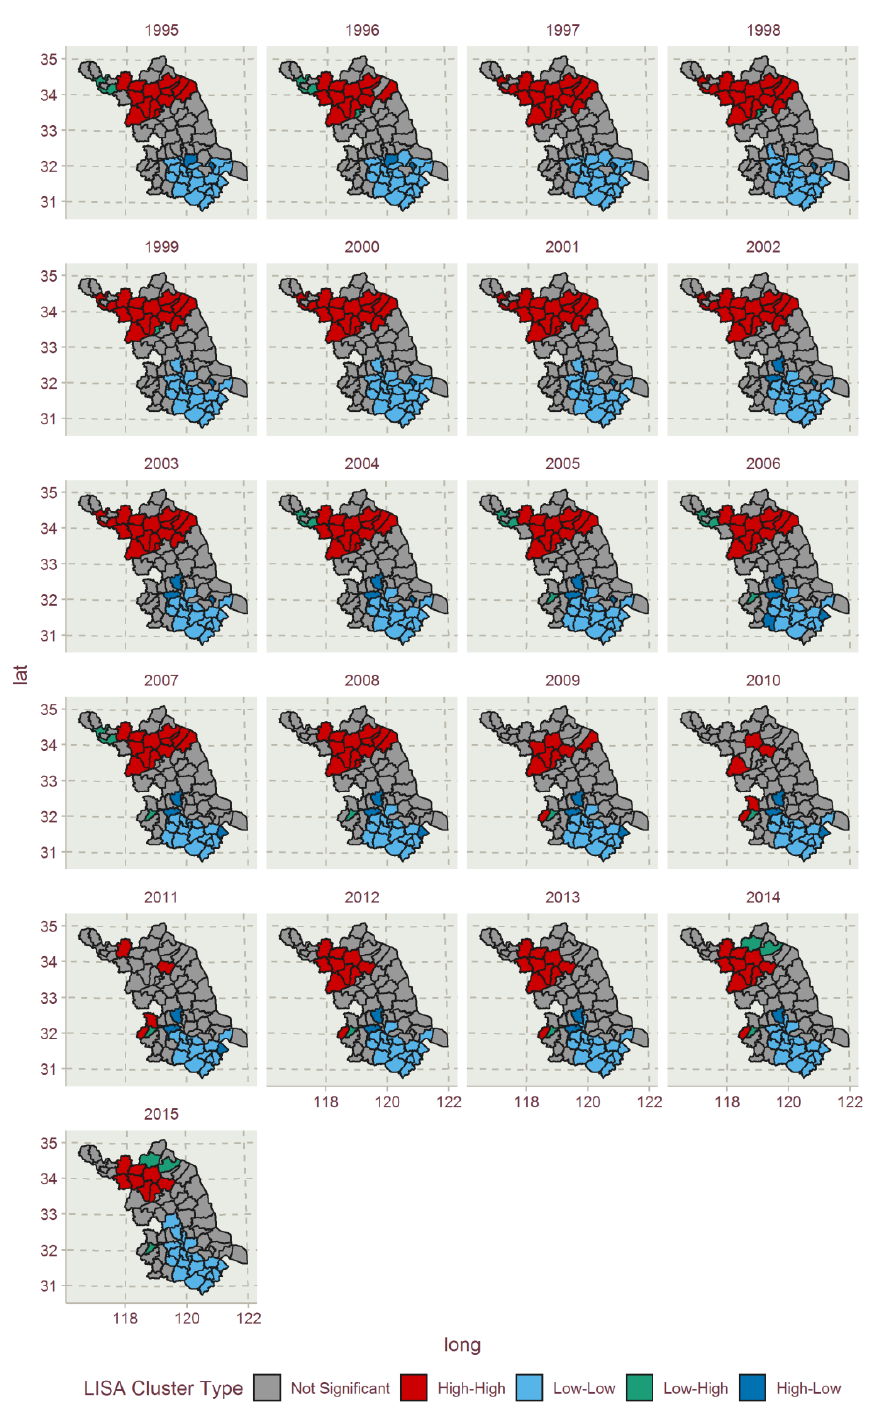
Figure 12. Spatial distribution of EFIs of Jiangsu Province in 1995 – 2015.